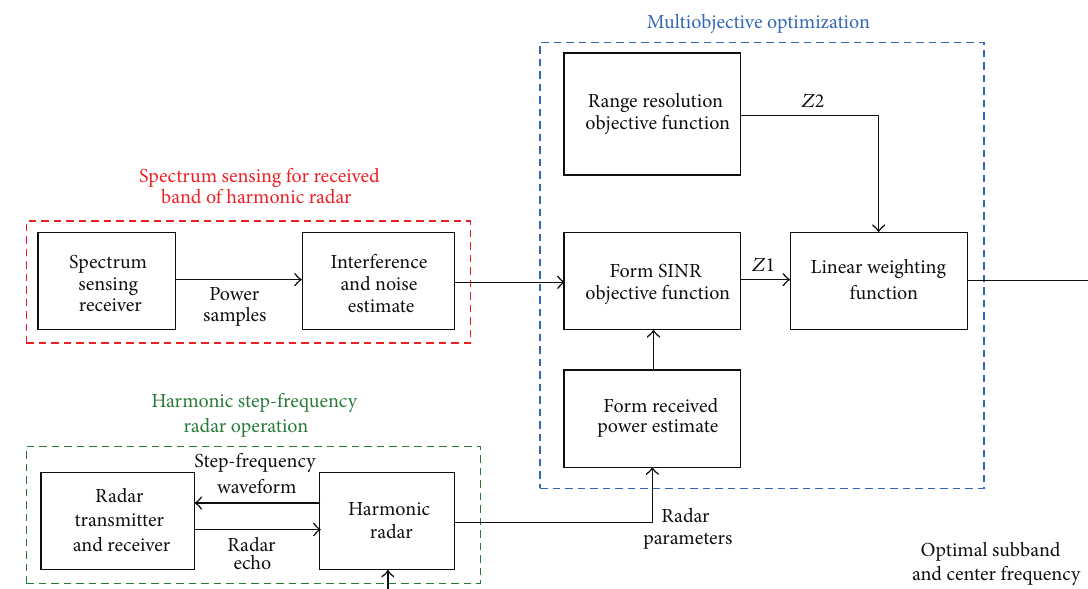
Figure 2: Proposed SS-MO technique for harmonic step-frequency radar. This technique requires an empirical measure of the RF spectrum. Multiobjective optimization is used to find a subband within the operational frequency band of the radar.